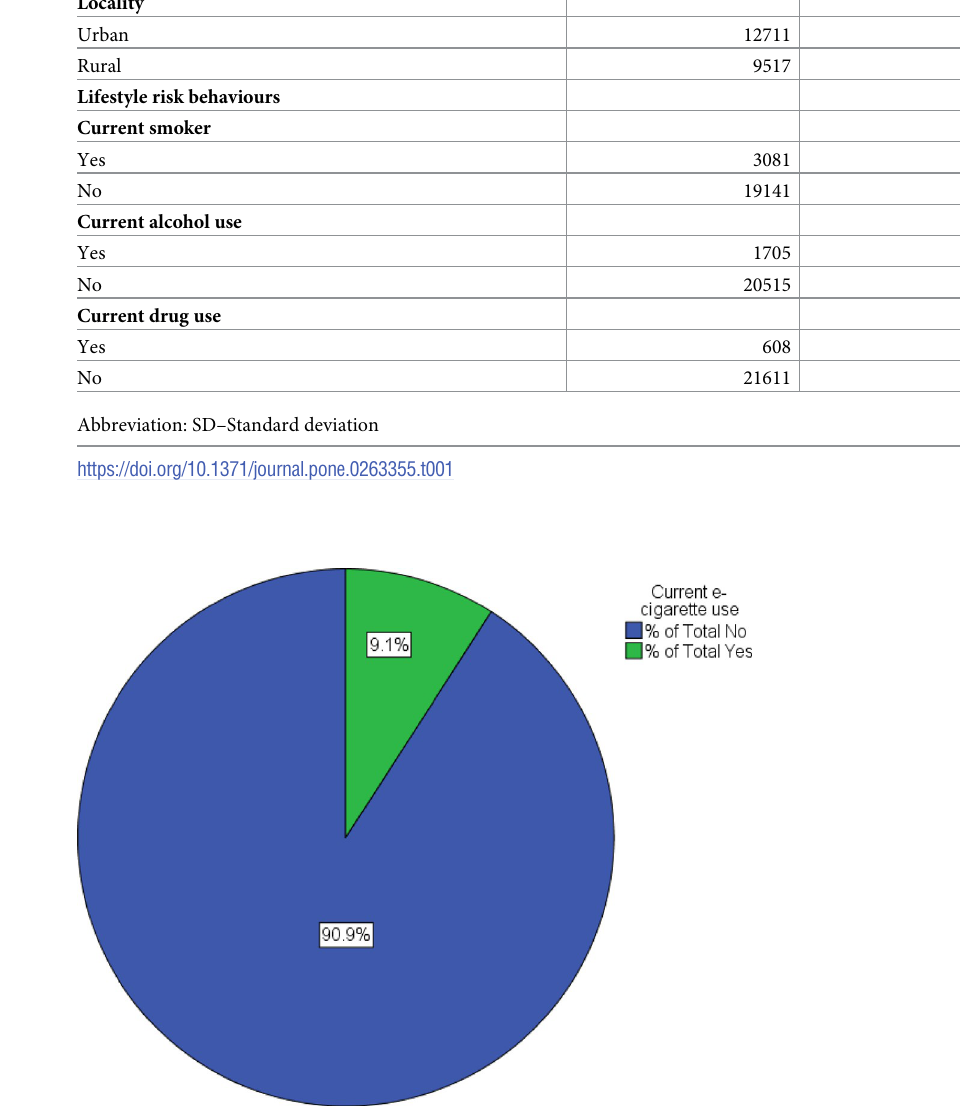
Fig 1. Prevalence of current e-cigarette use among in-school adolescents in West